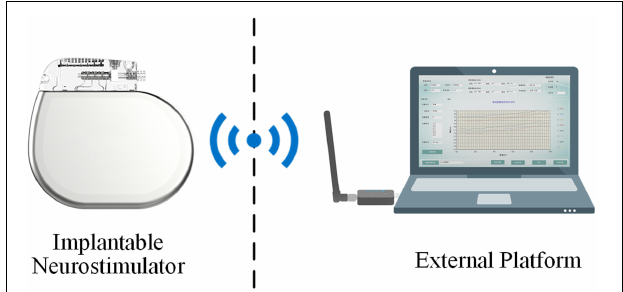
FIGURE 1 | Illustration of the sensing-enabled neurostimulator system.